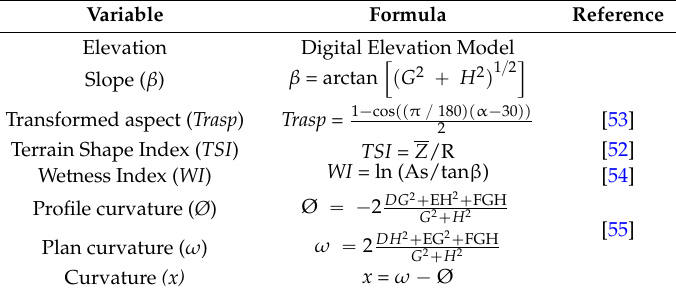
Table 2. Additional field variables used to model the aboveground forest biomass